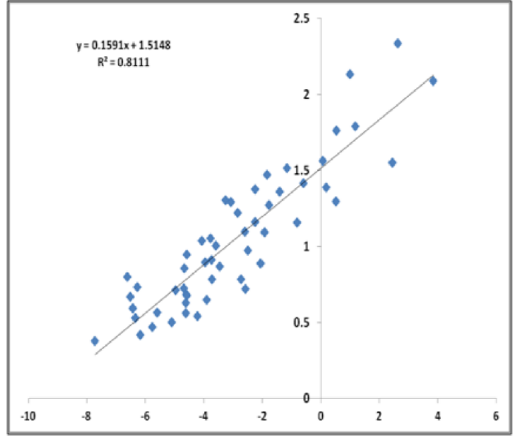
Figure 3. RMS (Y axis) against σ HH high (θ) - σ HH Low (θ) (X axis) 9. TOPP’S